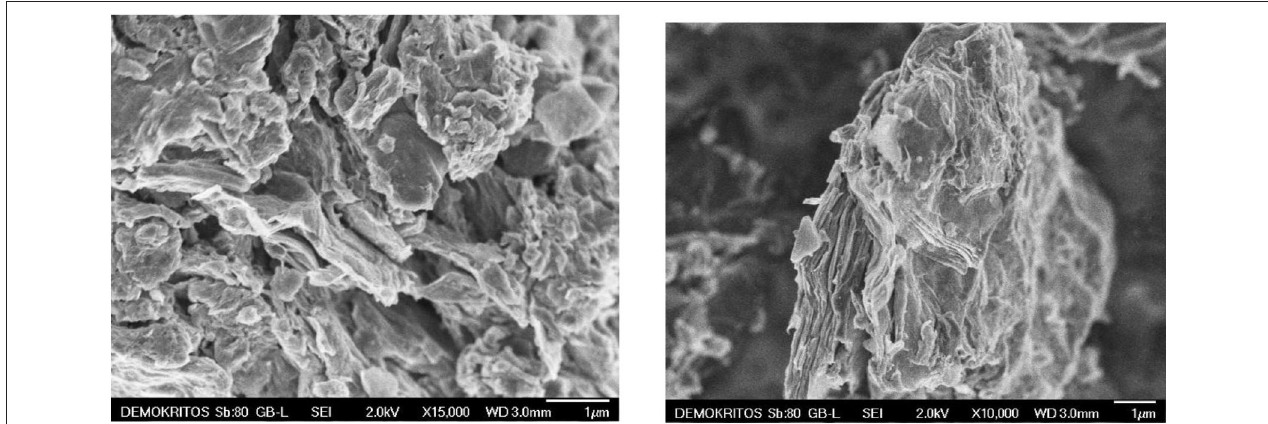
FIGURE 9 | SEM images of the heterostructure prepared by silylation of organo-modified graphene oxide with 1,4-Bis(triethoxysilyl)-benzene, and calcinated to give G-BTB.